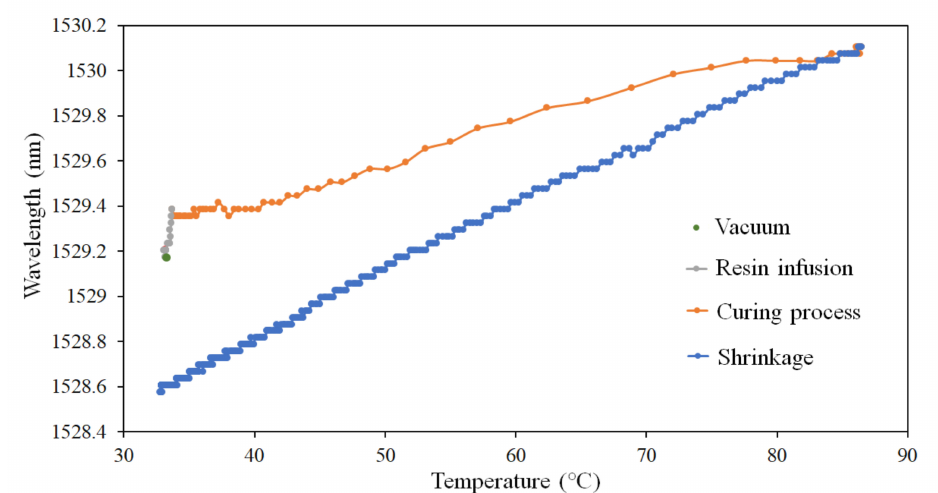
Figure 8. Wavelength shift and temperature change relationship